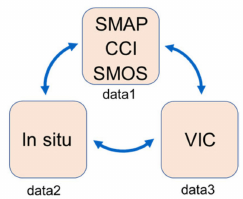
Figure 3. Three triplets of datasets triple collocation used in this study.